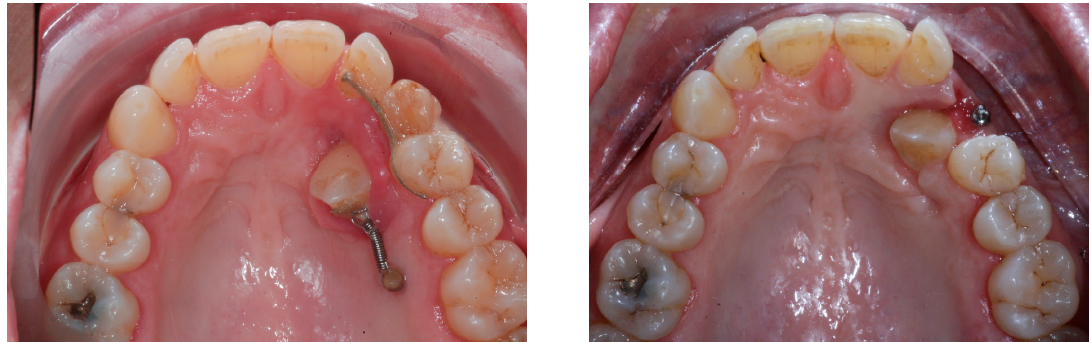
Figure 13. The TAD inserted on the palatial side mesially to the first molar and connected to the coil spring. away from the lateral incisor, and, at the same time, it was vertical in order to produce ex- trusion.